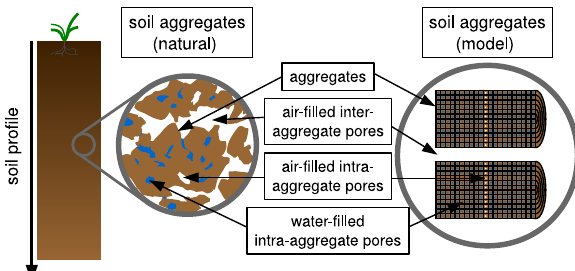
Fig. 4. Sketch of a soil profile with a cross-section of natural aggregates (left), and a representative of the cylindrical aggregates (right), used to model uptake/productionand diffusion of O 2 and CO 2 inside the aggregates. The boundary condition of the cylindrical aggregates is defined by the p O 2 and p CO 2 values in the air-filled inter-aggregatepores, calculated with the one-dimensionaldiffusion model.